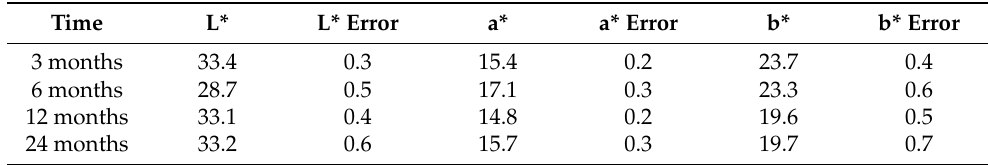
Table 3. Evolution of the L*, a* and b* coordinates of the natural patina with time at 95% confidence intervals.